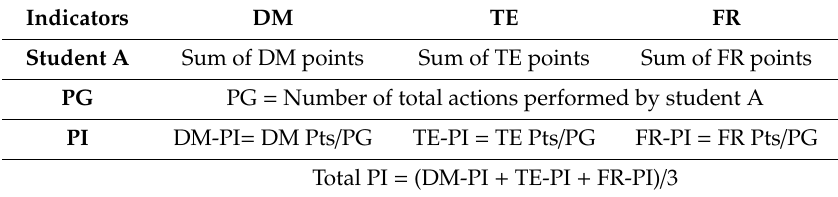
Table 3. Calculation of the game performance (GP) and PI